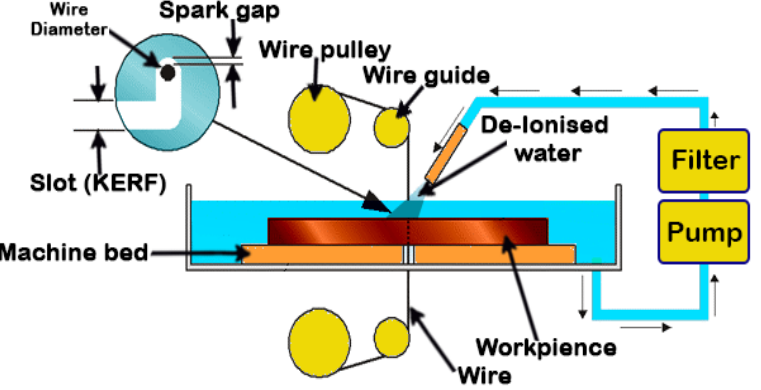
Figure 4. Schematic diagram of the wire EDM.